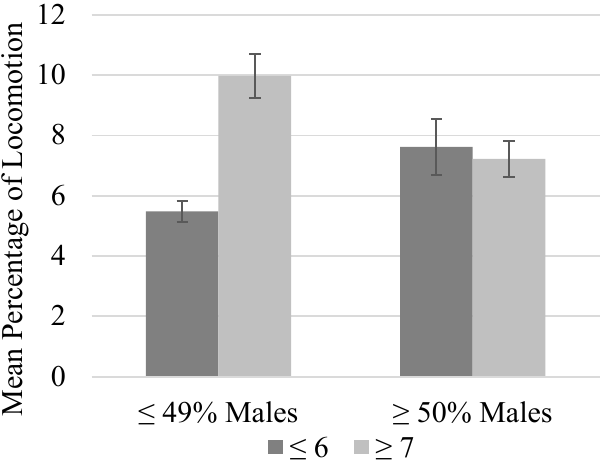
Figure 3. Mean percentage of time spent locomoting as a function of group size and percentage of males in the group. Error bars represent the standard error of the mean. Within smaller groups (six or fewer chimpanzees), locomotion was significantly higher when at least half the chimpanzees in the group were males ( p ≤ 0.05). Within larger groups (seven or more chimpanzees), the mean percent time spent locomoting was significantly higher in groups that comprised less than half male chimpanzees ( p ≤ 0.05). Lastly, the mean time spent locomoting was highest in larger groups that contained less than half male chimpanzees ( p ≤ 0.05).